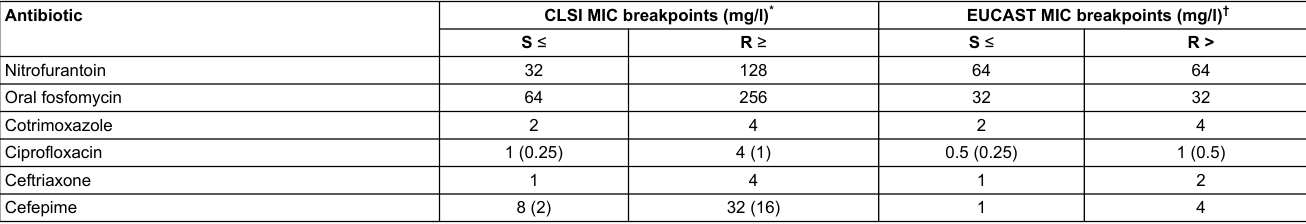
Table 1: CLSI and EUCAST minimum inhibitory concentration (MIC) breakpoints for Enterobacteriaceae for selected antibiotics.